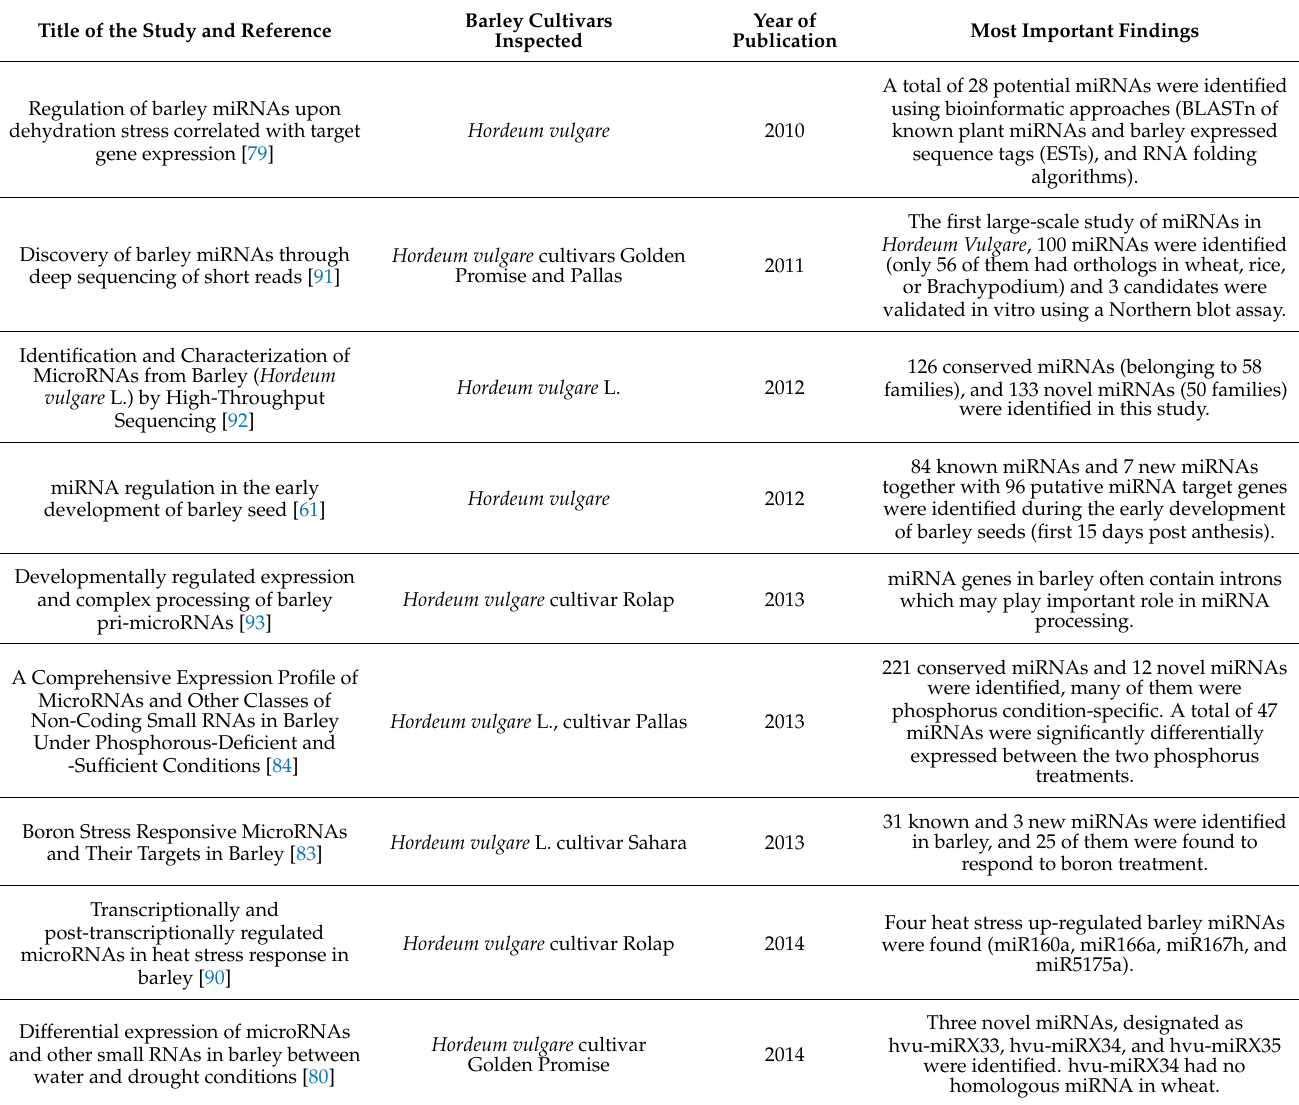
Table 1. Chronological summary of studies dealing with miRNAs in barley species and most important results